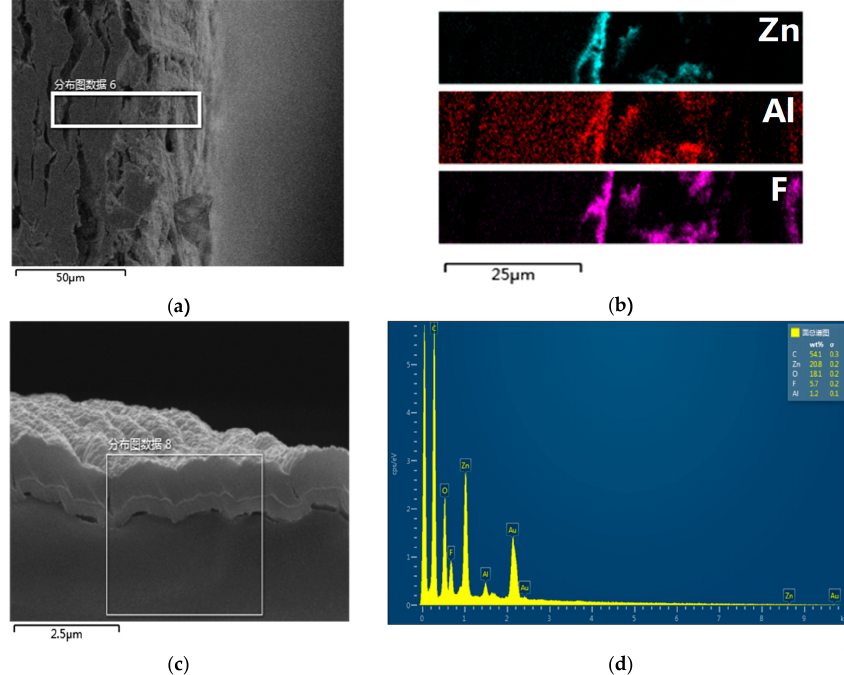
Figure 6. Scanning electron microscopy (SEM) image of sample Z10-A60-P30 after cross-section polishing at 1k× magnification ( a ) and element mapping of the selected area ( b ); scanning electron microscopy (SEM) image of sample Z10-A60-P30 at 1 5k× magnification, ( c ) and energy dispersive